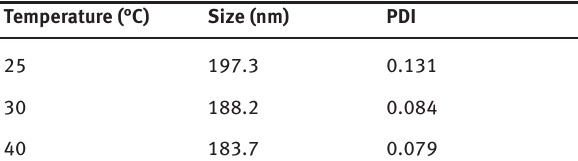
Table 3: Effect of mixing temperature on preparation of GB-LM. Temperature (°C)